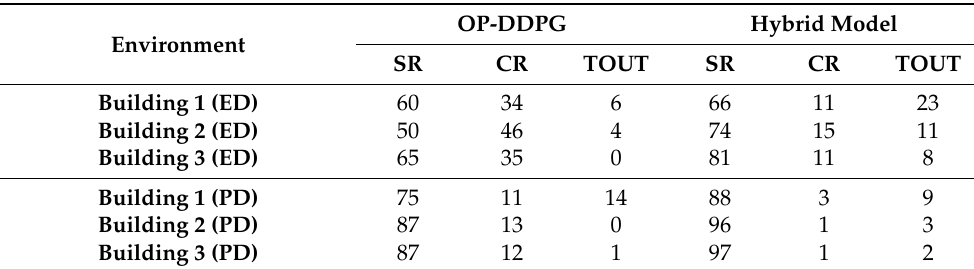
Table 1. OP-DDPG and Hybrid Model comparison in static environments for Euclidean and path distance cases.